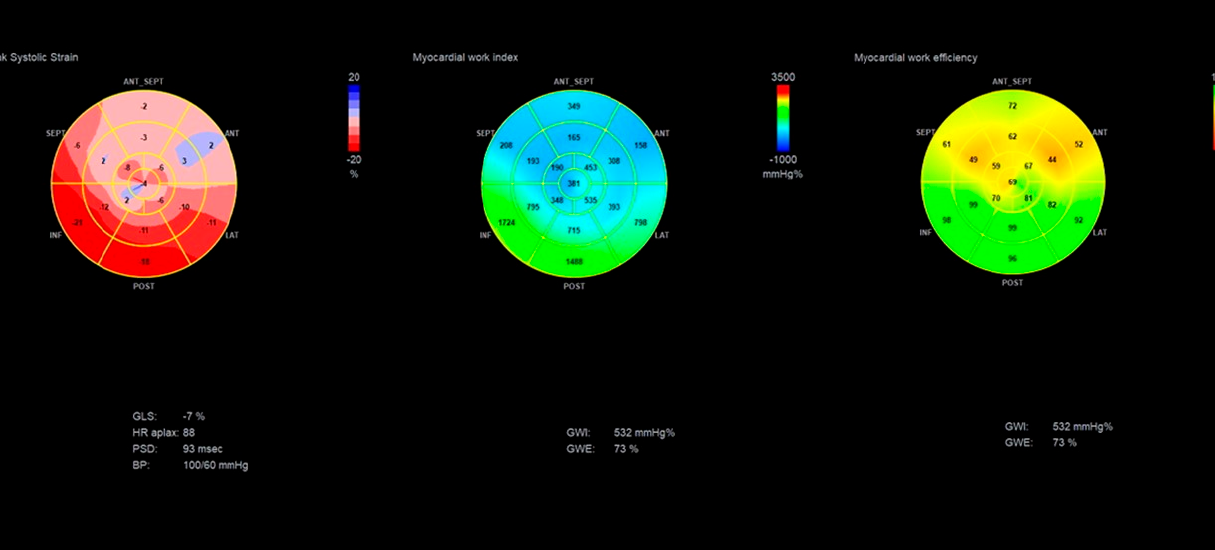
Figure 5. Bull’s eye of GLS, GWI, and GWE showing global and segmental values in a patient with ischemic cardiomyopathy. GLS= − 7%, GWI = 532 mmHg%, GWE = 73%.